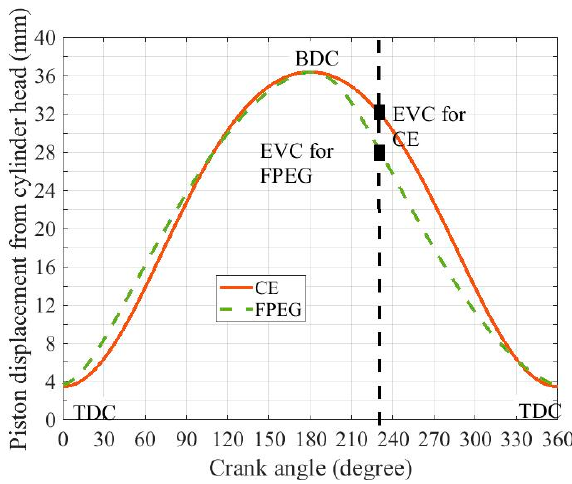
Figure 6. Valve timing of CE and FPEG with valve scavenging type.